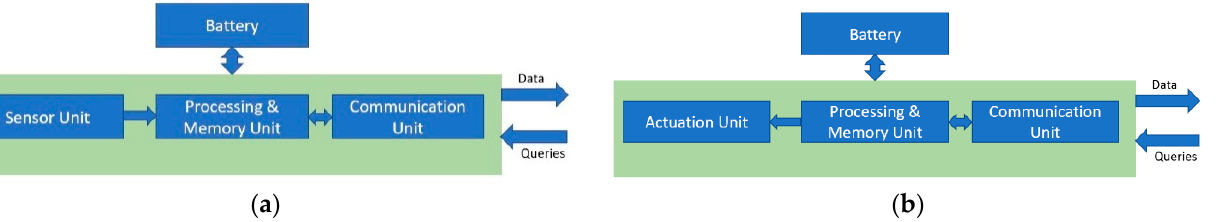
Figure 3. The architecture of ( a ) a wireless sensor ( b ) a wireless actuator.